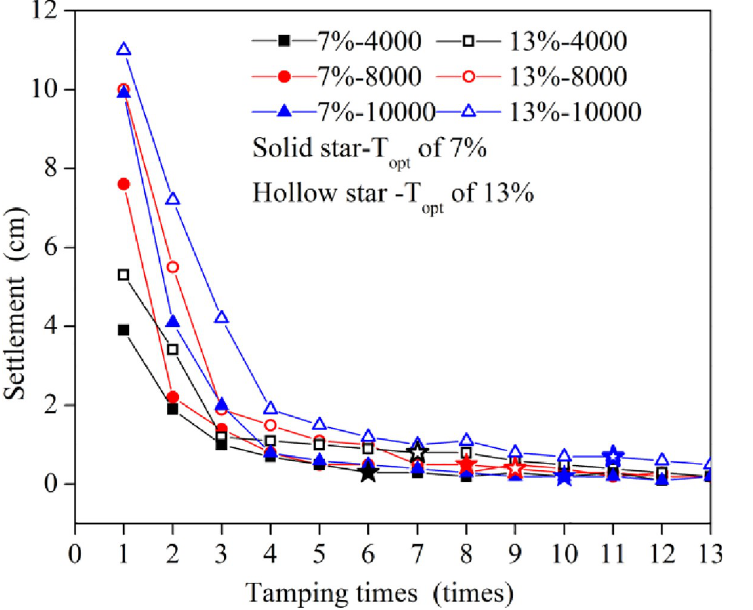
Fig 4. Curves of the settlement verses tamping